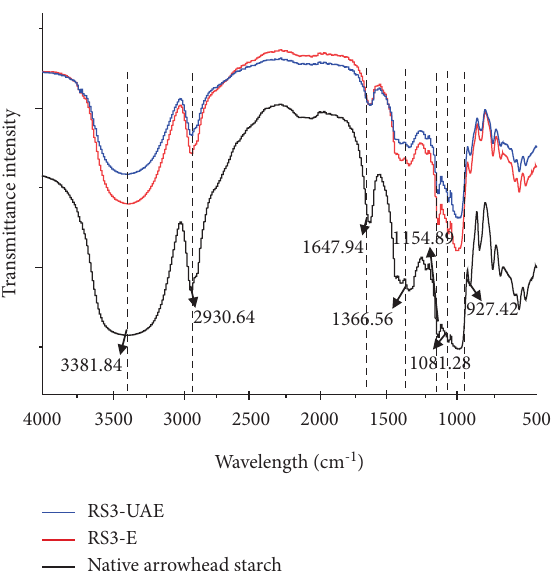
Figure 4: FTIR spectral changes in native arrowhead starch, RS3-E, and RS3-UAE. RS3-E type 3 resistant starch prepared by traditional- enzymolysis; RS3-UAE type 3 resistant starch prepared by ultrasound-assisted